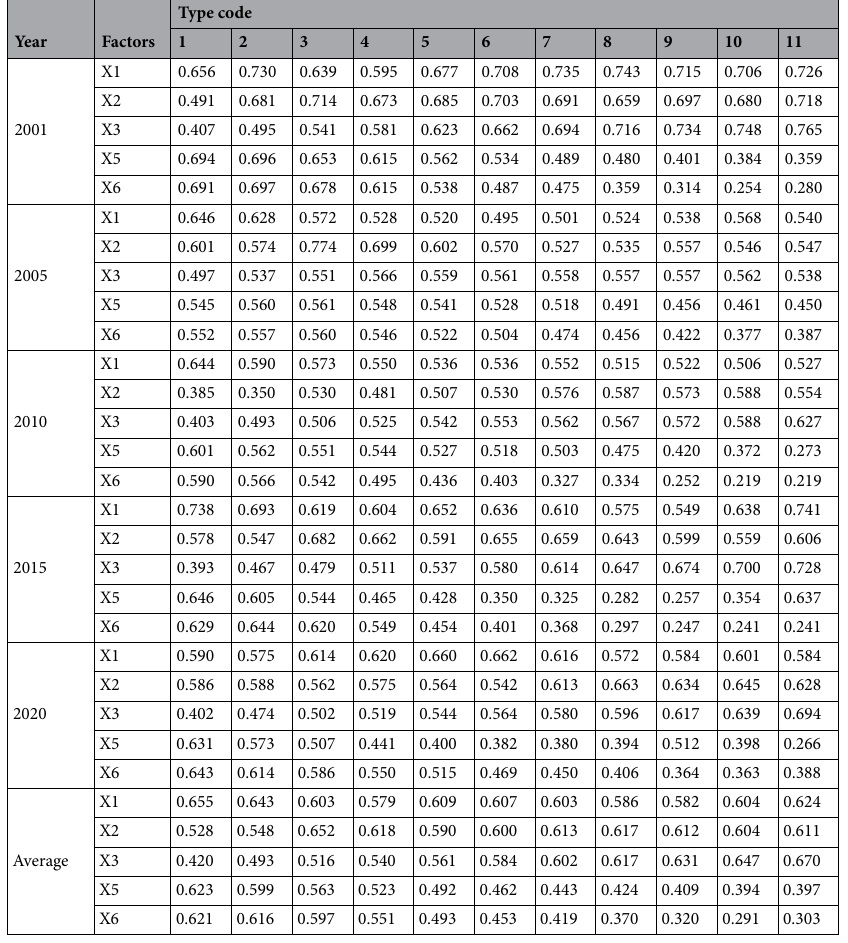
Table 10. RSEI corresponds to the type codes of X1, X2, X3, X5, and X6 (confidence level 95%).